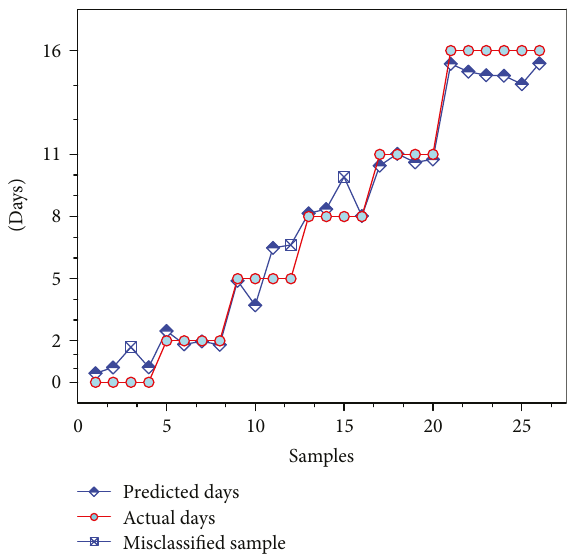
Figure 8: The predicted results of SDAE-NN model for test sets of the salmon meat.